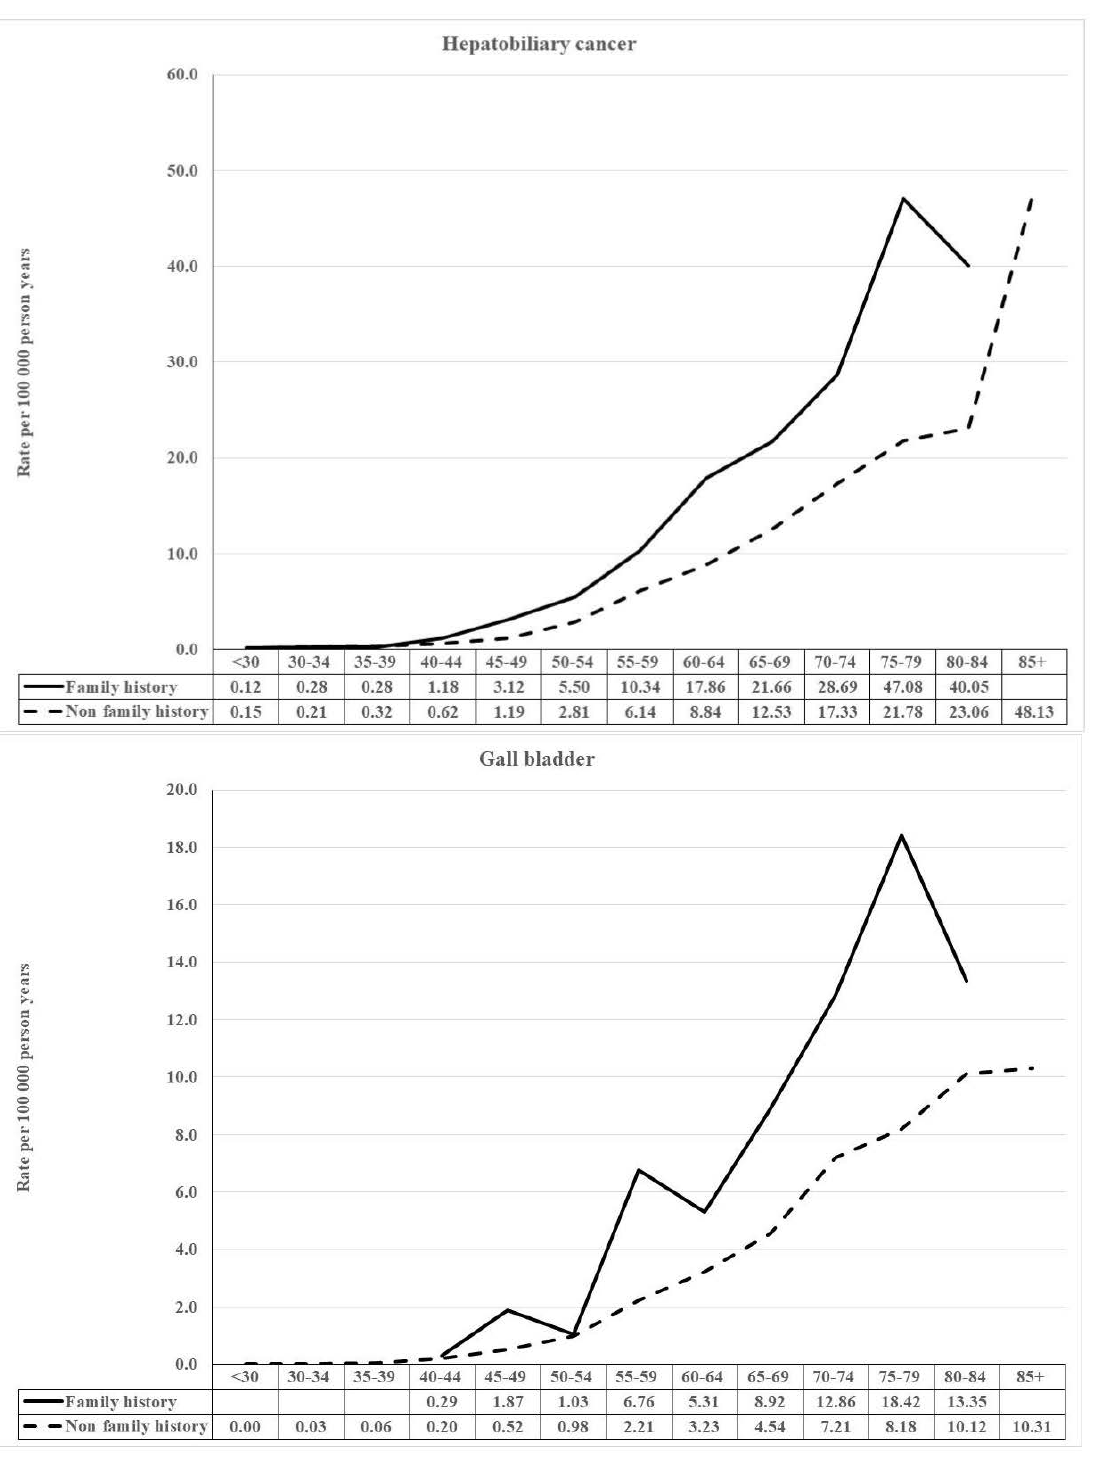
Figure 2. Age-specific incidence for familial and nonfamilial hepatocellular carcinoma and gallbladder cancer with incidence rate ratios.